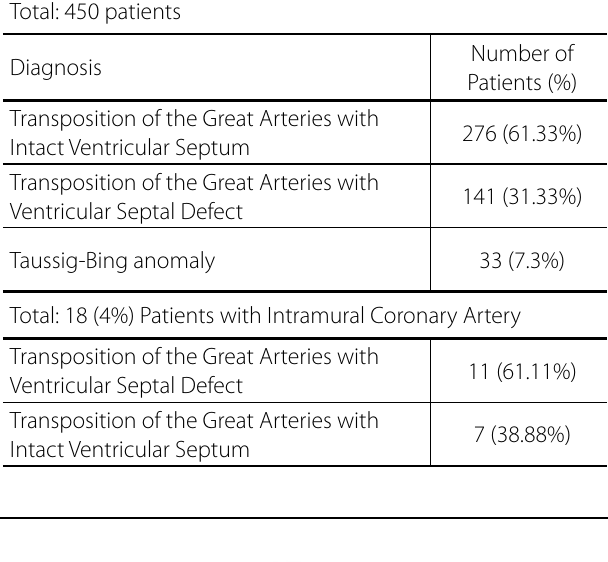
Table 1. Details of the patients who underwent arterial switch operations.